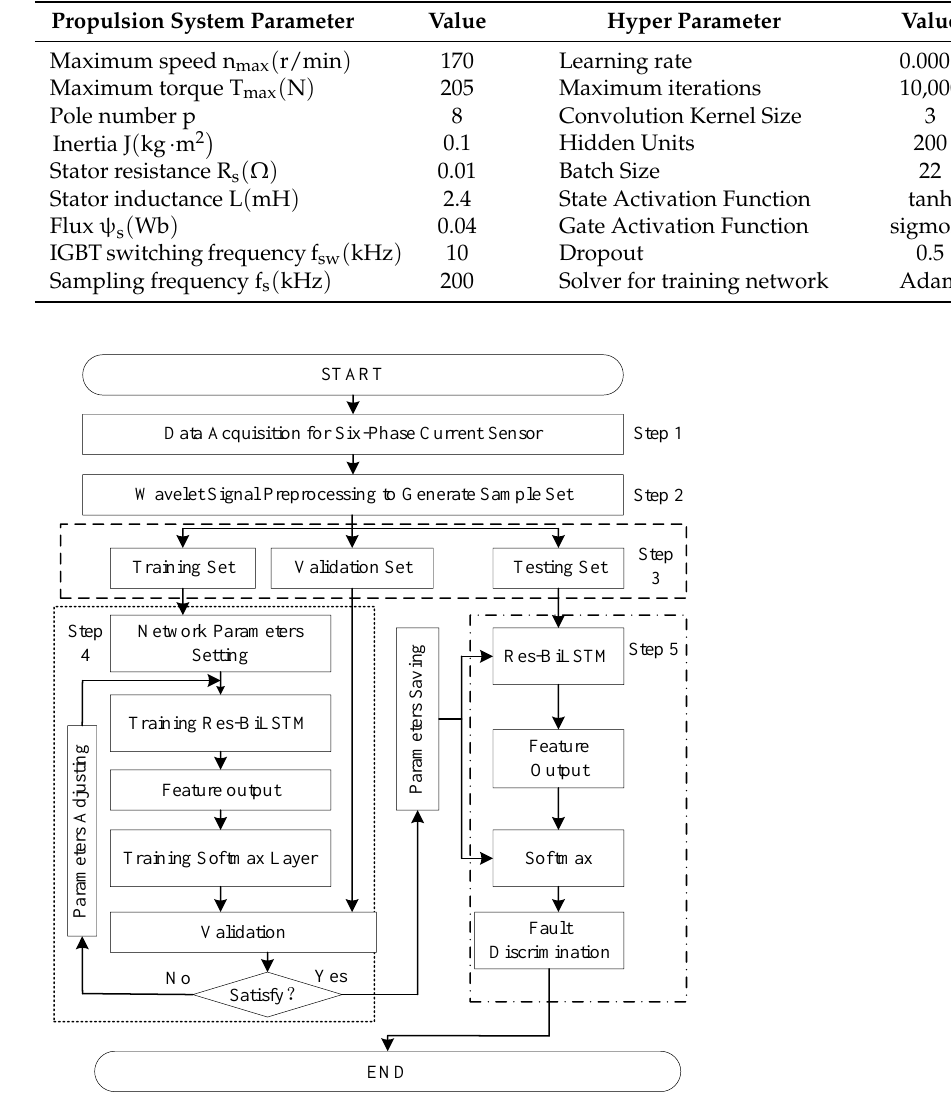
Figure 11. Flow Diagram of the Proposed Res-Bilstm Fault Diagnosis Architecture.